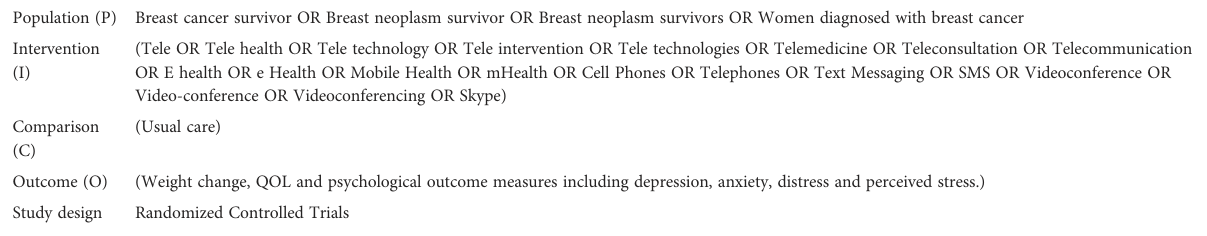
TABLE 1 Search strategy - PICOS